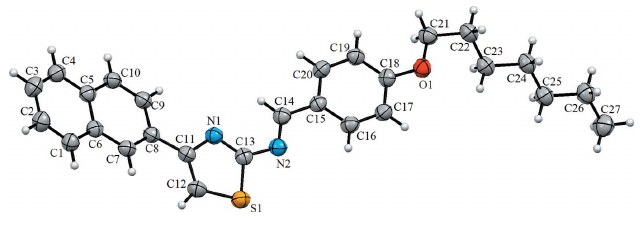
Figure 1 The molecular structure of the title compound, with atom labelling. Displacement ellipsoids are drawn at the 40% probability level.